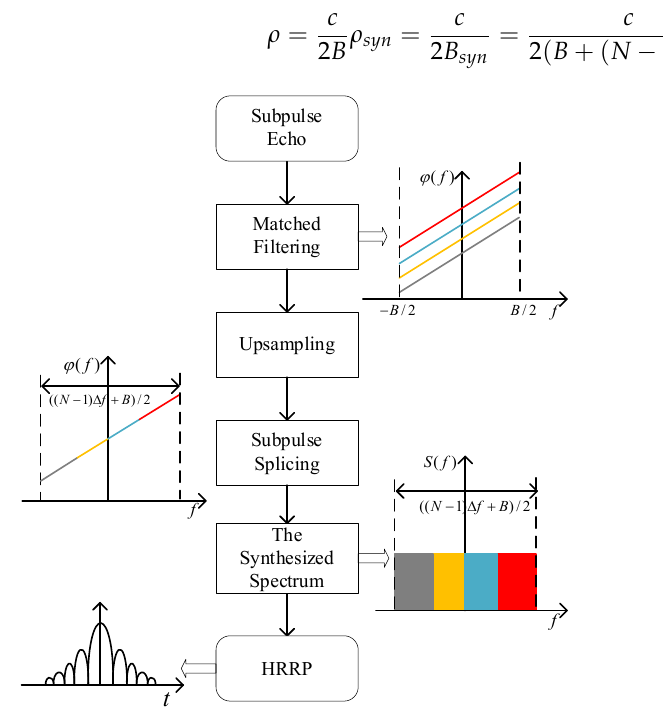
Figure 1. Frequency domain wideband synthesis of LFM waveform.